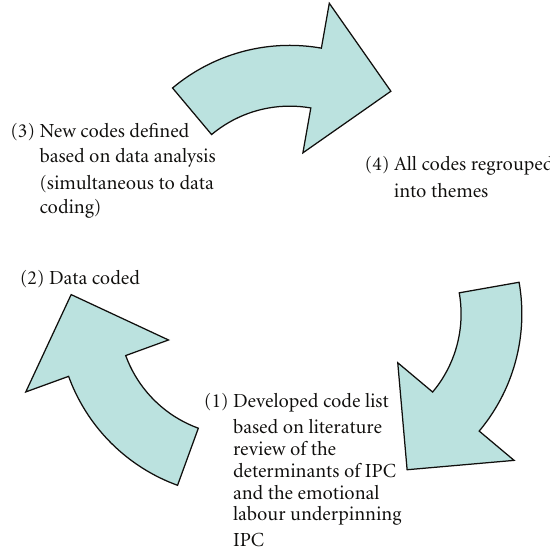
Figure 1: Steps in data analysis and data